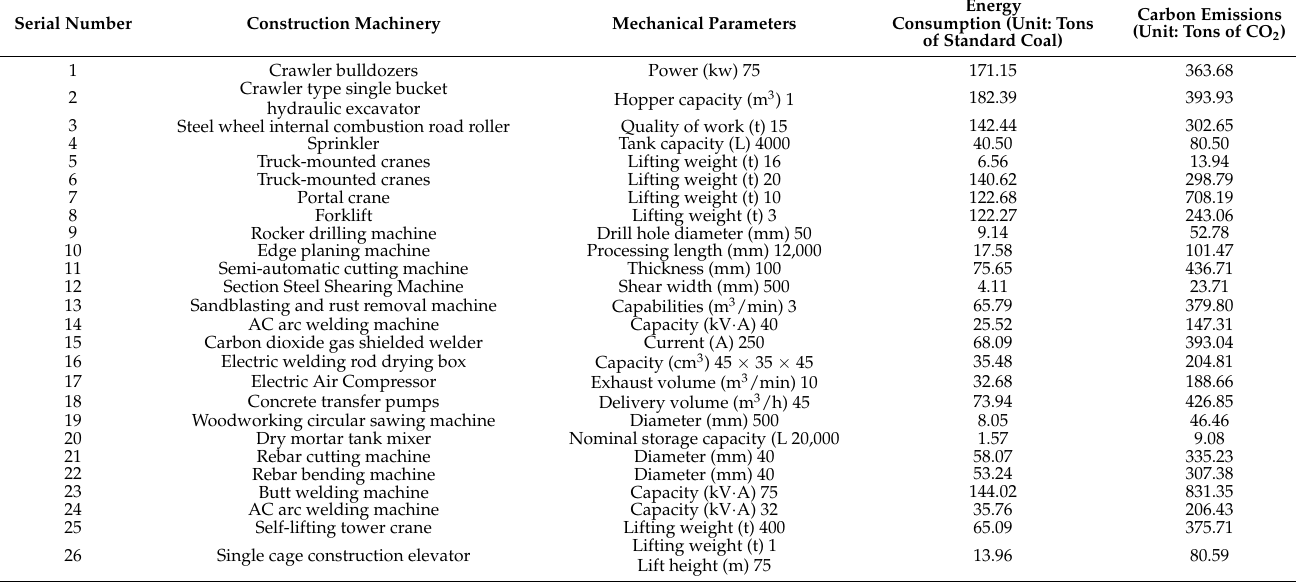
Table 6. Energy consumption and carbon emissions of various types of construction